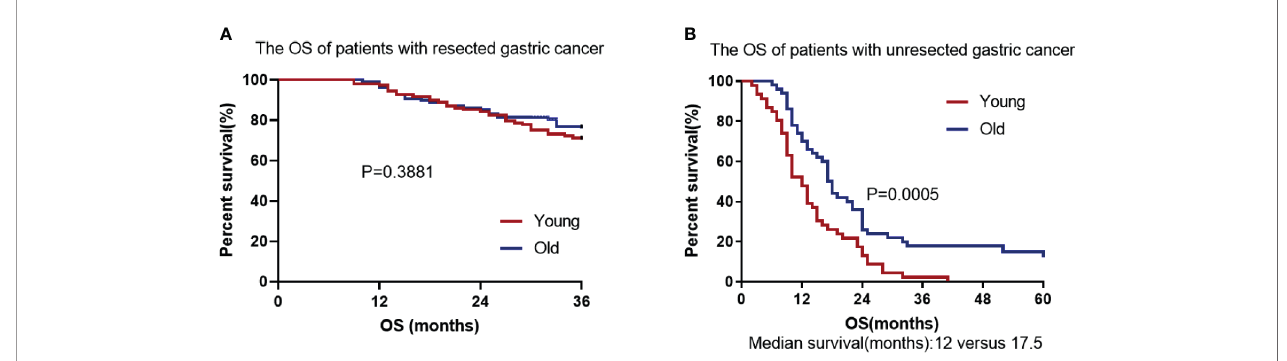
FIGURE 5 | Cumulative survival in EOGC and LOGC patients with resected or unresected GC. (A) There was no difference in overall survival between resected EOGC group and LOGC group; P = 0.3881 (log-rank test). (B) There was statistical signi fi cance in overall survival between unresected EOGC group and LOGC group; P = 0.0005 (log-rank